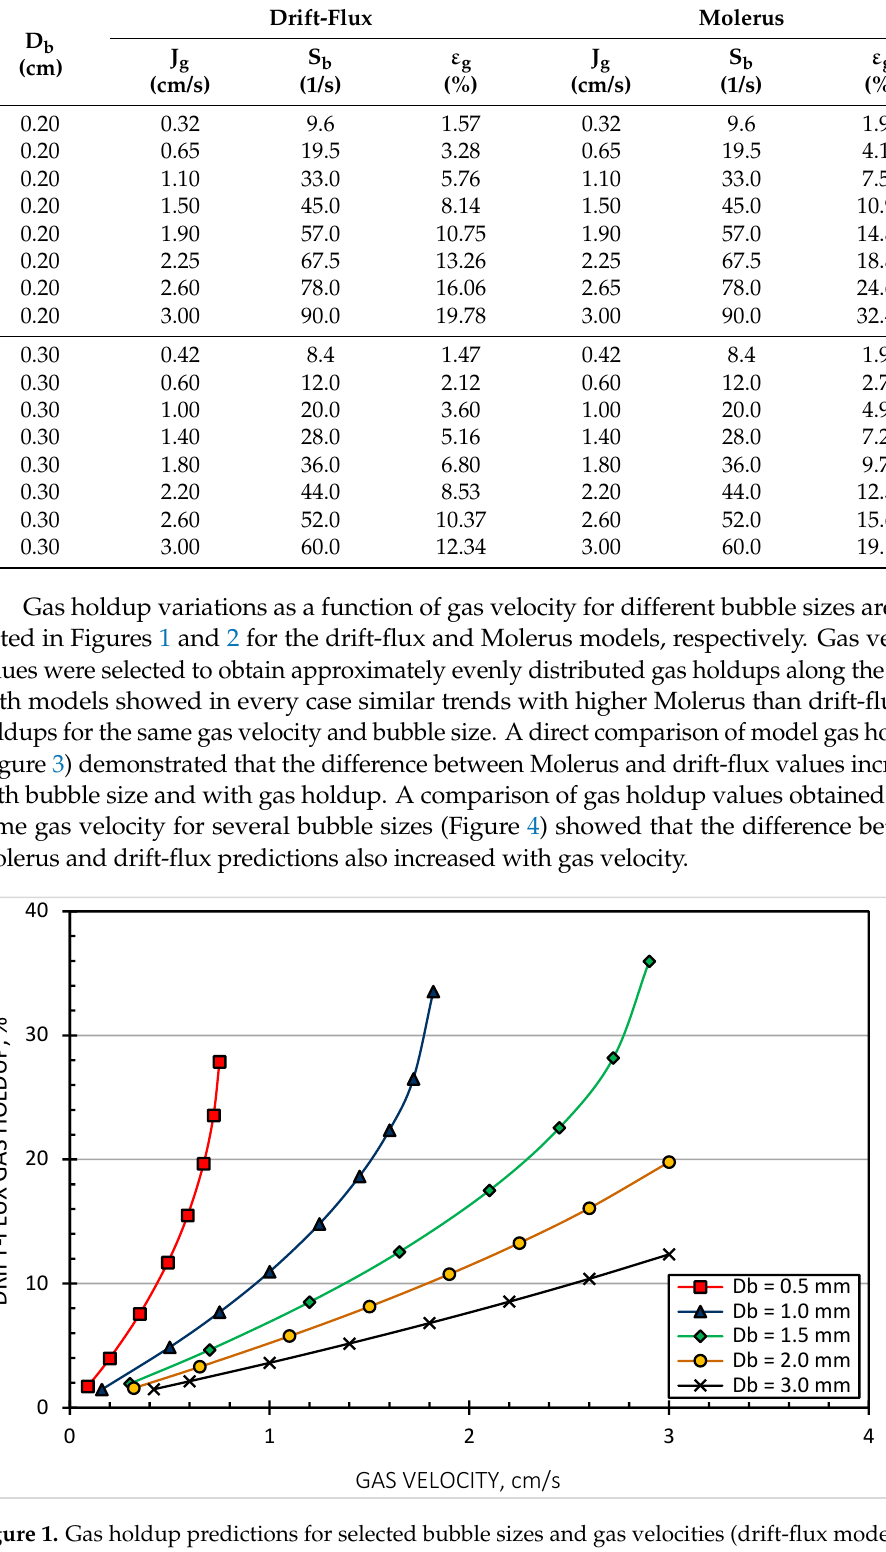
Figure 2. Gas holdup predictions for selected bubble sizes and gas velocities (Molerus model).